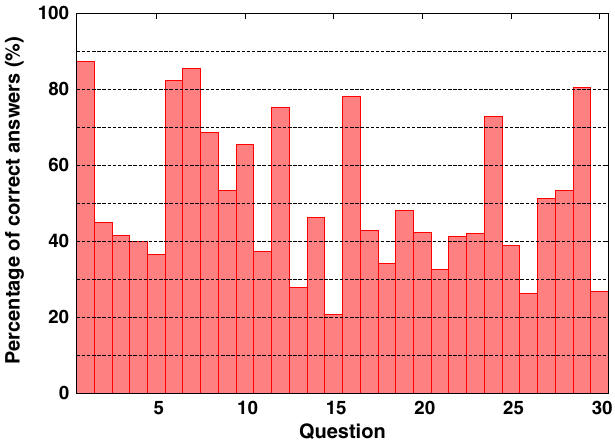
FIG. 2 (color online). Ratio of the correct answers depicted in percentage of the total number of respondents. Horizontal axis represents the